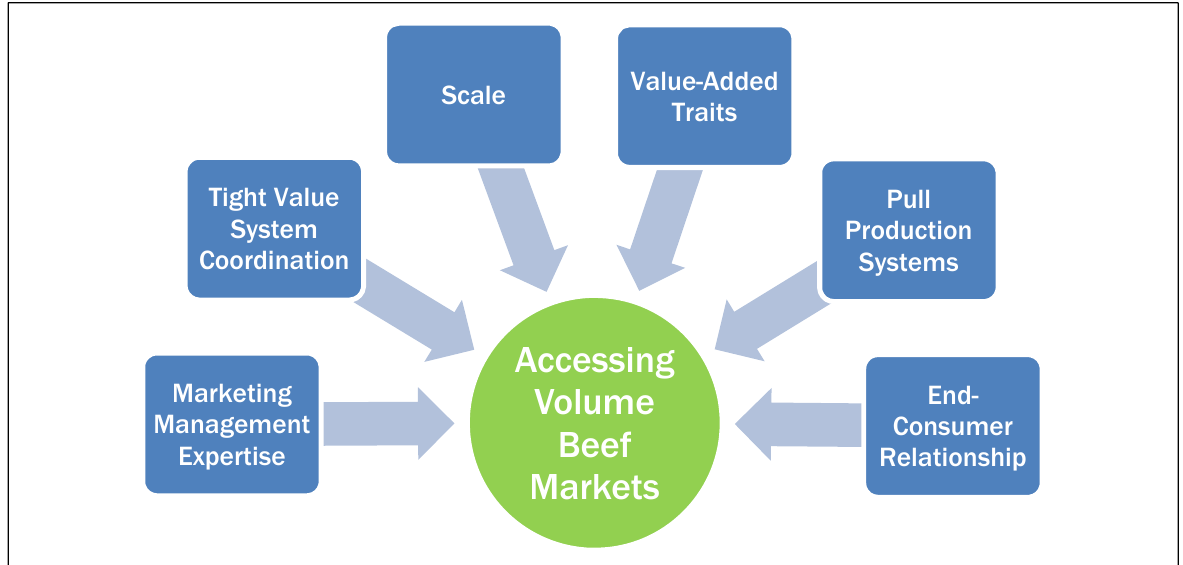
Figure 4. A New Model for Small